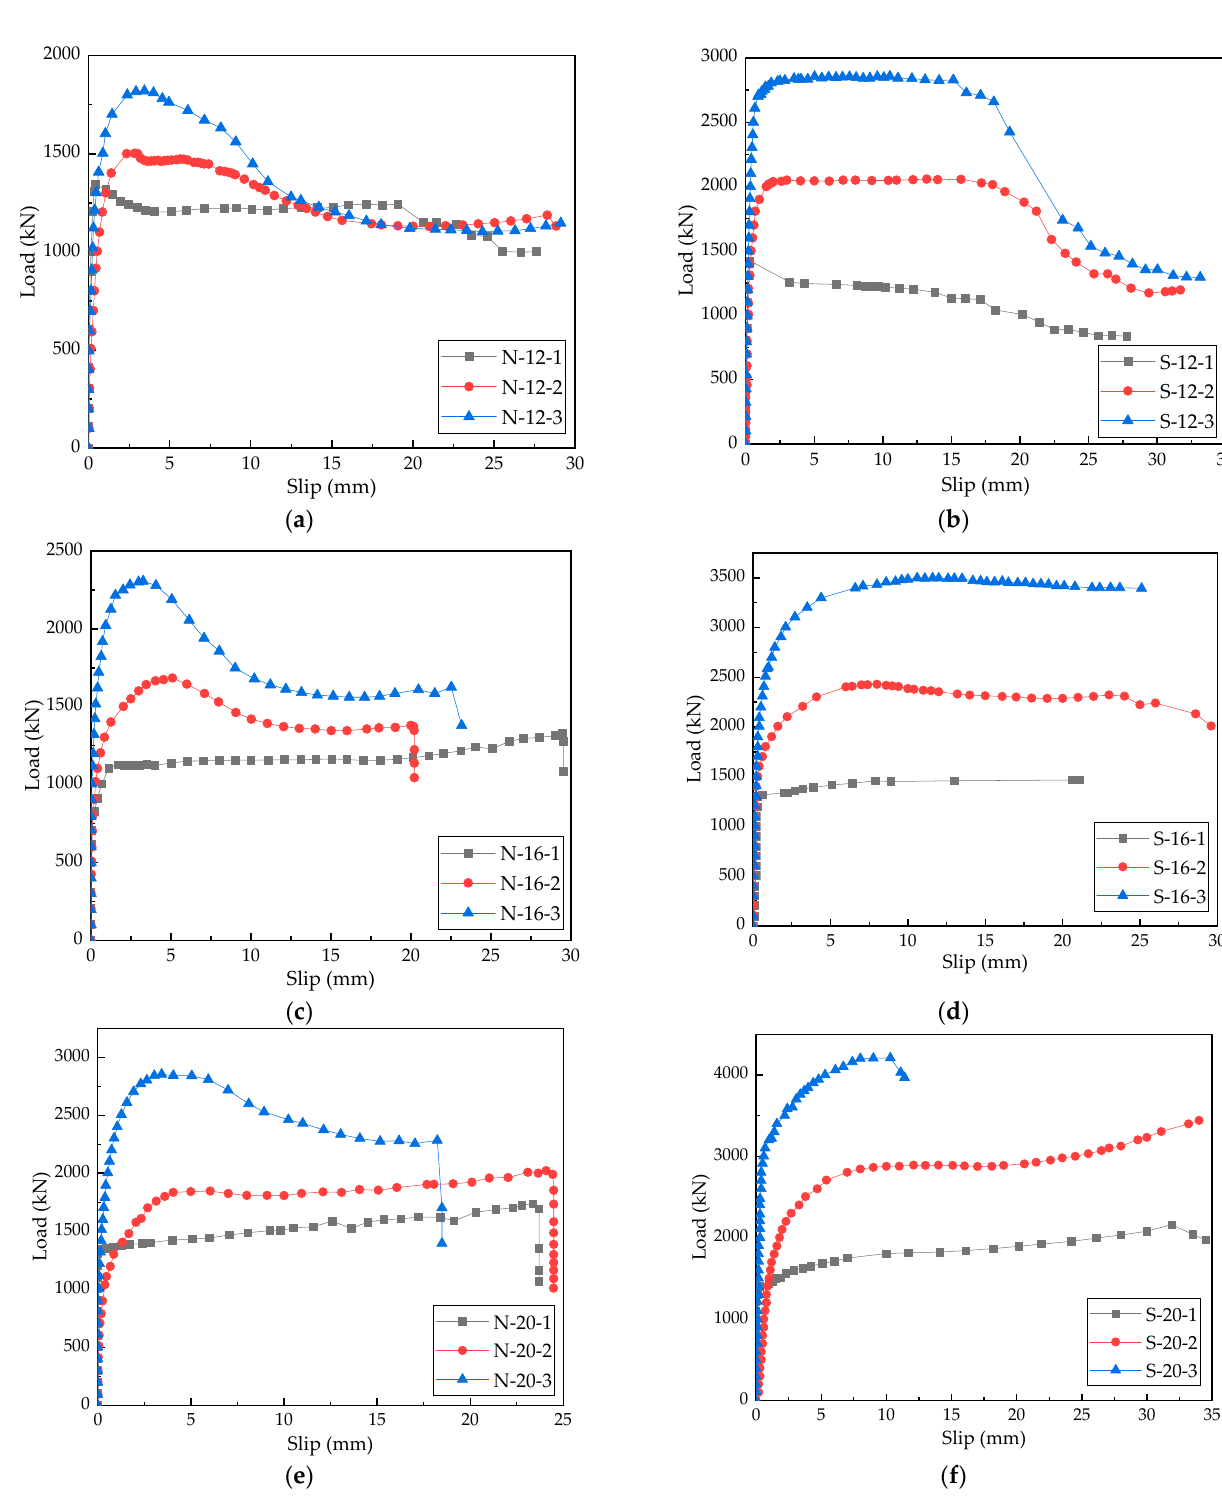
Figure 6. Load–slip curves of specimens: ( a ) N-12; ( b ) S-12; ( c ) N-16; ( d ) S-16; ( e ) N-20; and ( f ) S-20. When the failure occurred, the ultimate slip amount of the steel–SFRCC composite structure was larger than that of the steel–NC composite structure. This happened because due to the presence of steel fibers in the steel–SFRCC composite structure, cracks were not developed rapidly after their appearance; thus, the structure continued to bear the load. However, the failure of the steel–NC composite structure was faster due to the second- order effect of cracks.